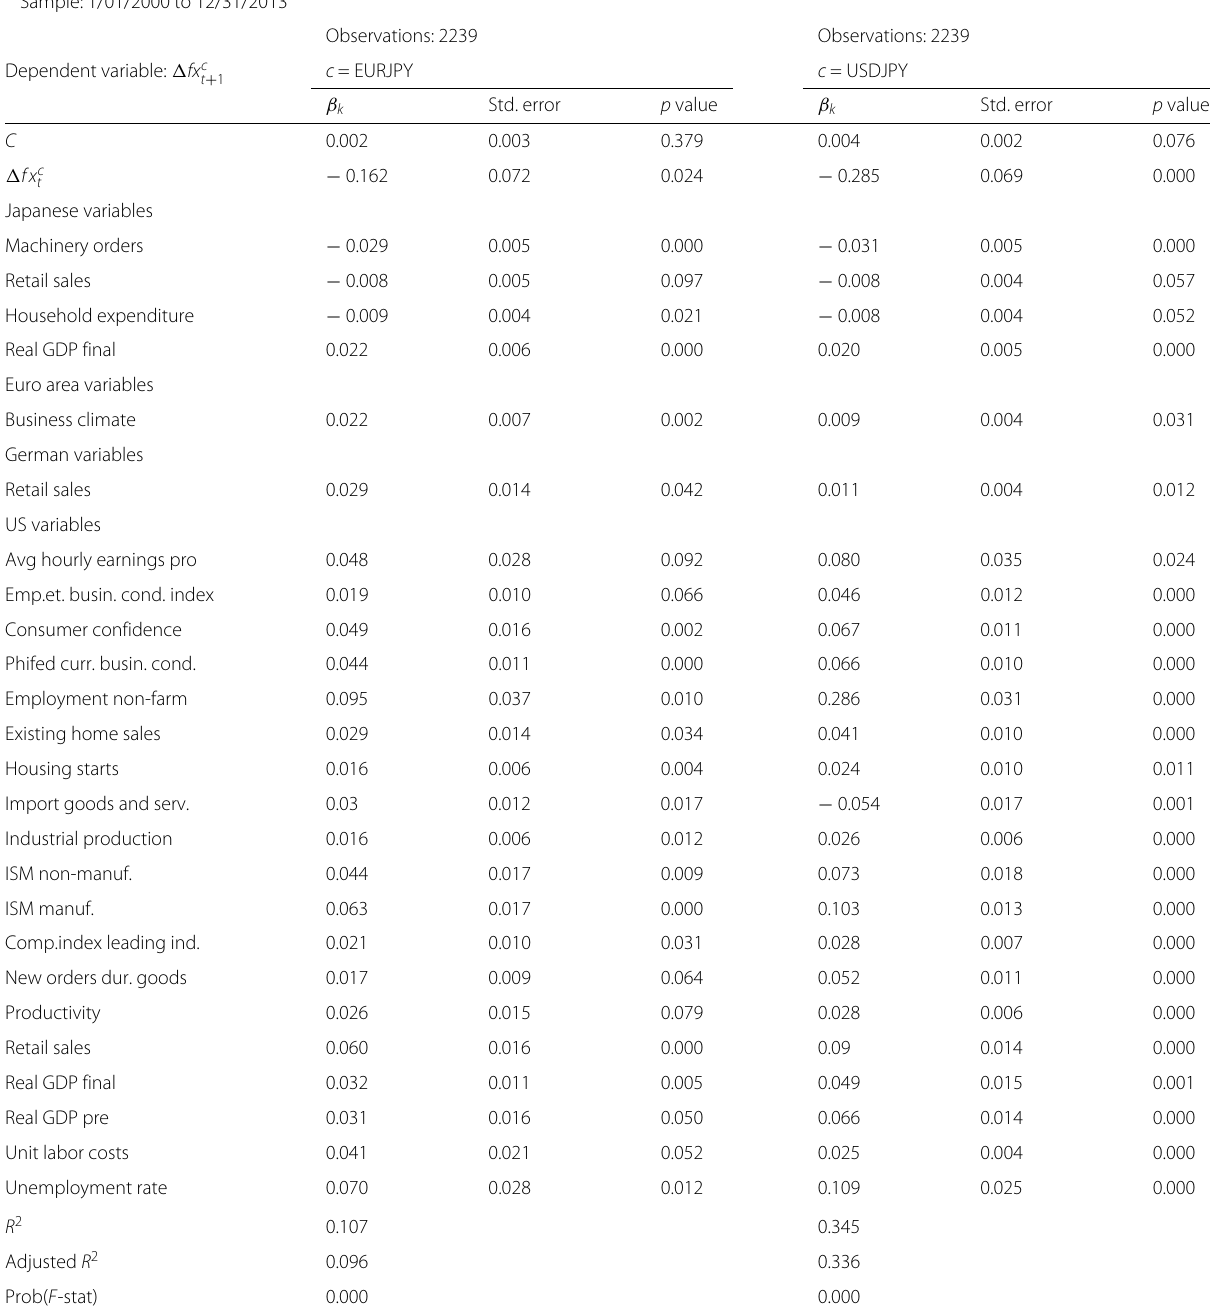
Table 2 Full-sample estimates for the JPY Sample: 1/01/2000 to